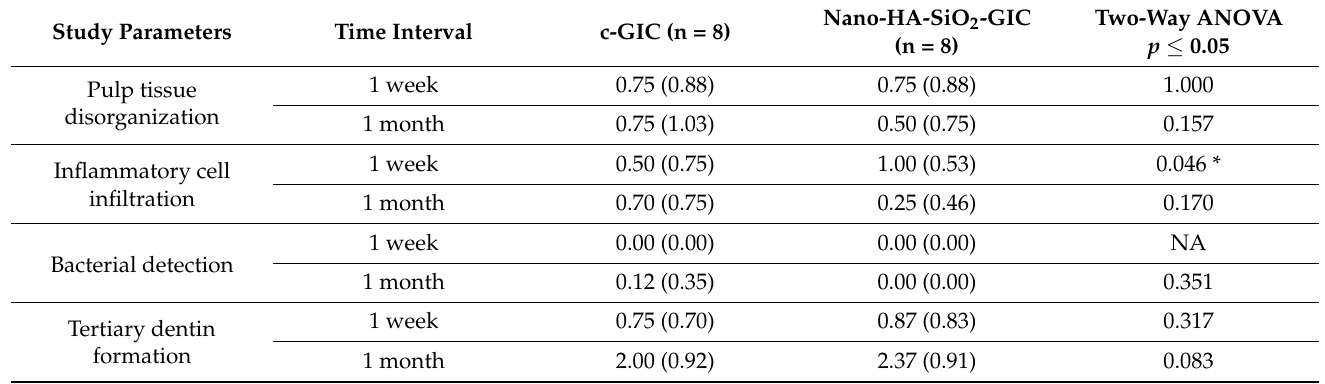
Table 3. Mean score and SD of dentin–pulp complex response for cervical c-GIC and nano-HA-SiO 2 - GIC at each experimental time